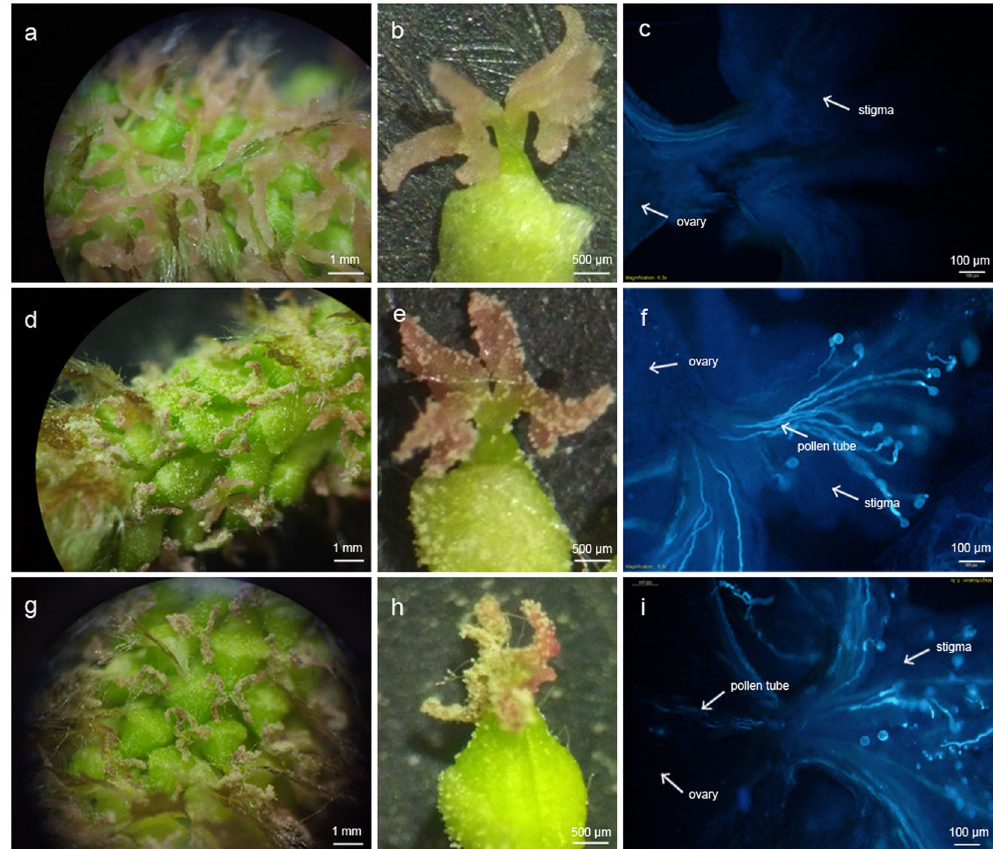
Figure 1. Morphological changes of pistil and pollen tube. ( a,b and c ) Represent observations made in samples collected at 0 h. Female flowers in middle positon of catkin were in the best pollination period and stigma crack angle was about 180°, but no pollen germination on surface of stigma. ( d , e and f ) Were samples obtained at 12 h, and a large number of pollen germinated and pollen tube grew in style. ( g,h and i ) Were collected at 24 h. Stigma senescence occurred and the tip of pollen tube had entered in ovary.